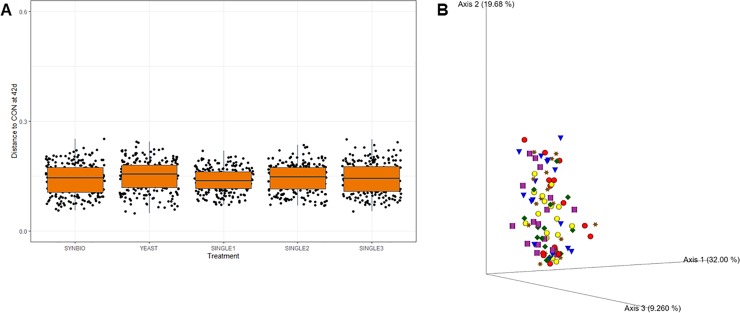
Weighted and unweighted UniFrac measurements of cecal microbiota in broilers at 42 days of age.(A) Pairwise comparison based on weighted Unifrac distances between cecal microbial communities. (B) Principal coordinate analyses plot based on unweighted UniFrac showing similarity of cecal samples from broilers fed a basal diet with no treatment (CON- red sphere), synbiotic (SYNBIO- dark orange star), yeast-based probiotic (YEAST- purple cylinder), or single-strain formulations composed of Bacillus amyloliquefaciens (SINGLE1- yellow sphere), B. subtilis (SINGLE2- green diamond), and B. licheniformis (SINGLE3- blue cone) by 42 days of age.